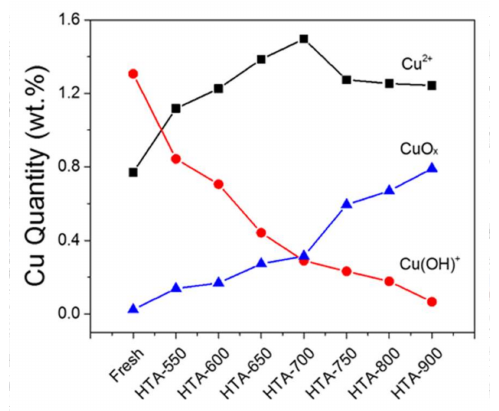
Figure 6. Estimation of Cu 2+ , Cu(OH) + and CuO x in fresh and hydrothermally aged Cu/SSZ-13 samples with Si/Al = 12 and Cu/Al = 0.25. HTA represents hydrothermal aging. Reprinted